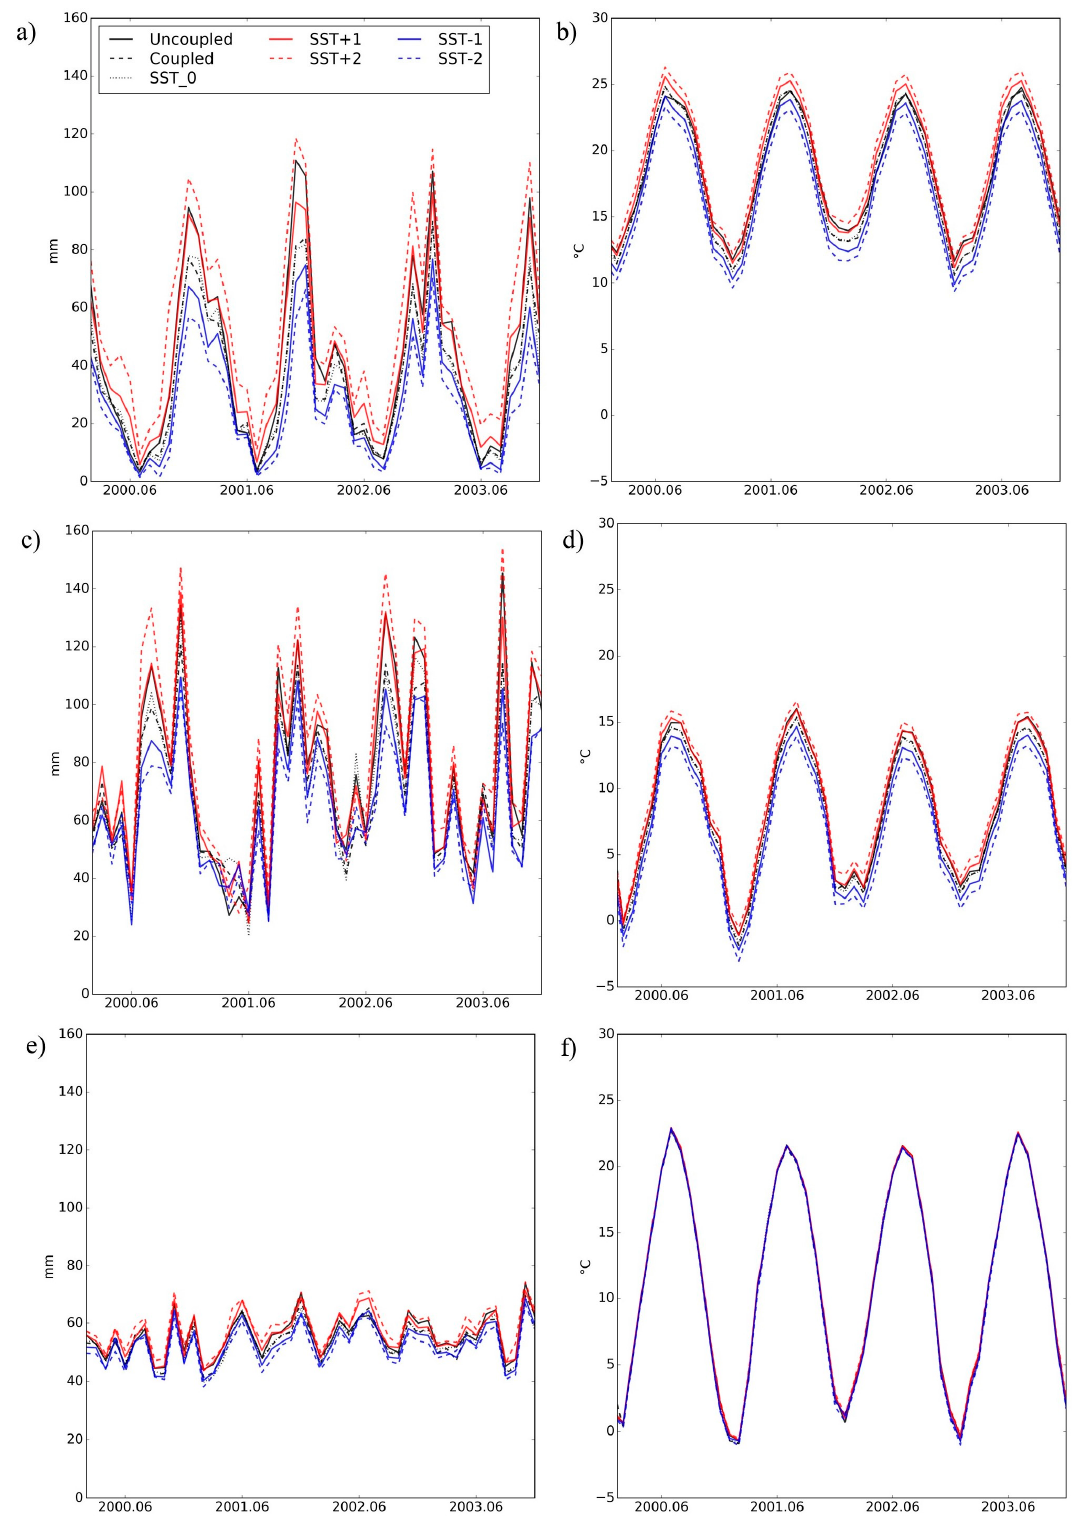
Figure 2. Time evolution (2000–2003) of precipitation (left column) and 2 m temperature (right column) field mean over the Mediterranean Sea ( a , b ), the Baltic and the North Seas ( c , d ) and over land ( e , f ) in the sensitivity experiments and in the coupled and uncoupled simulation.